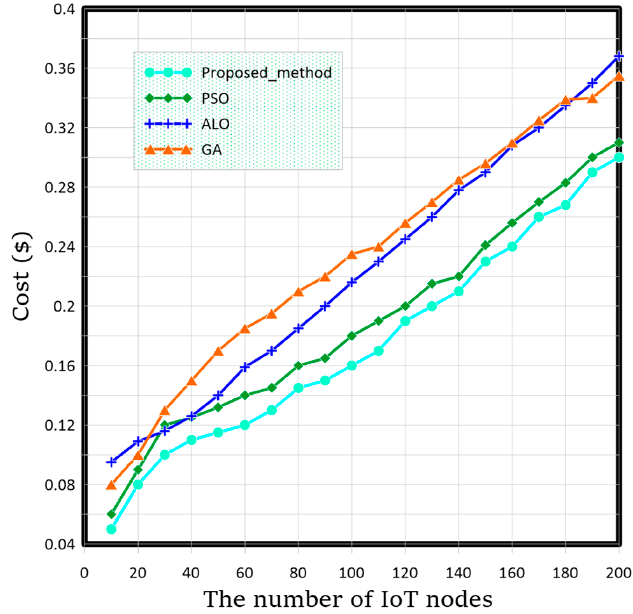
Figure 8. Comparison of the cost between the proposed method, PSO, ALO, and GA algorithms.